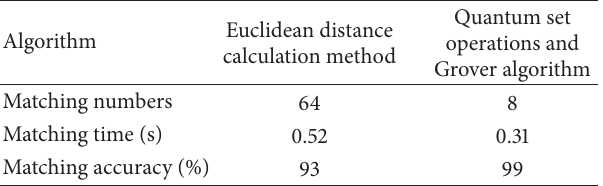
Table 1: The same palmprint experiment results of traditional algorithm and our algorithm.